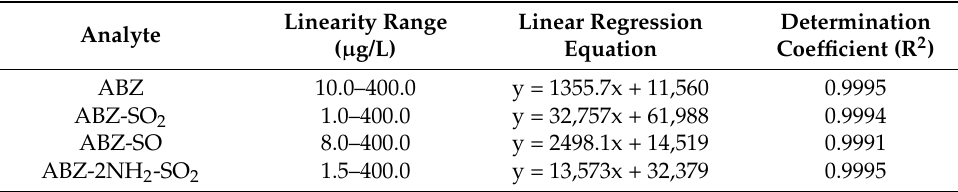
Table 2. The linearity range, linear regression equation and determination coefficient of ABZ, ABZ- SO 2 , ABZ-SO and ABZ-2NH 2 -SO 2 (n = 5).